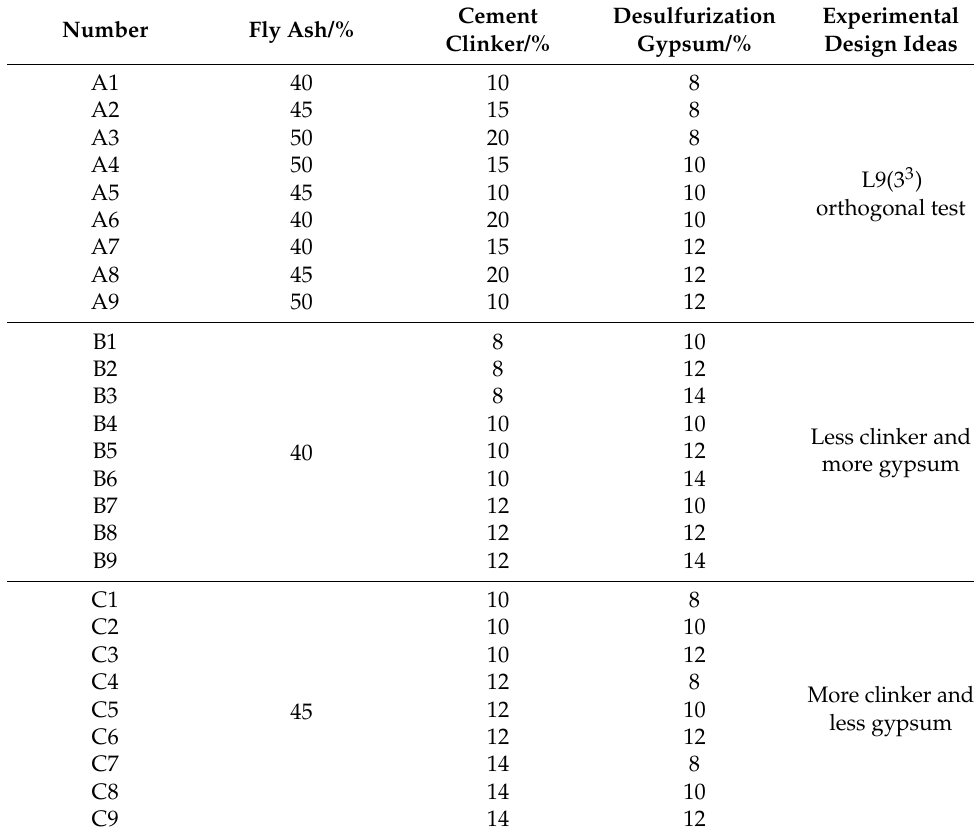
Table 4. Fly ash composite cementitious material cementitious strength test